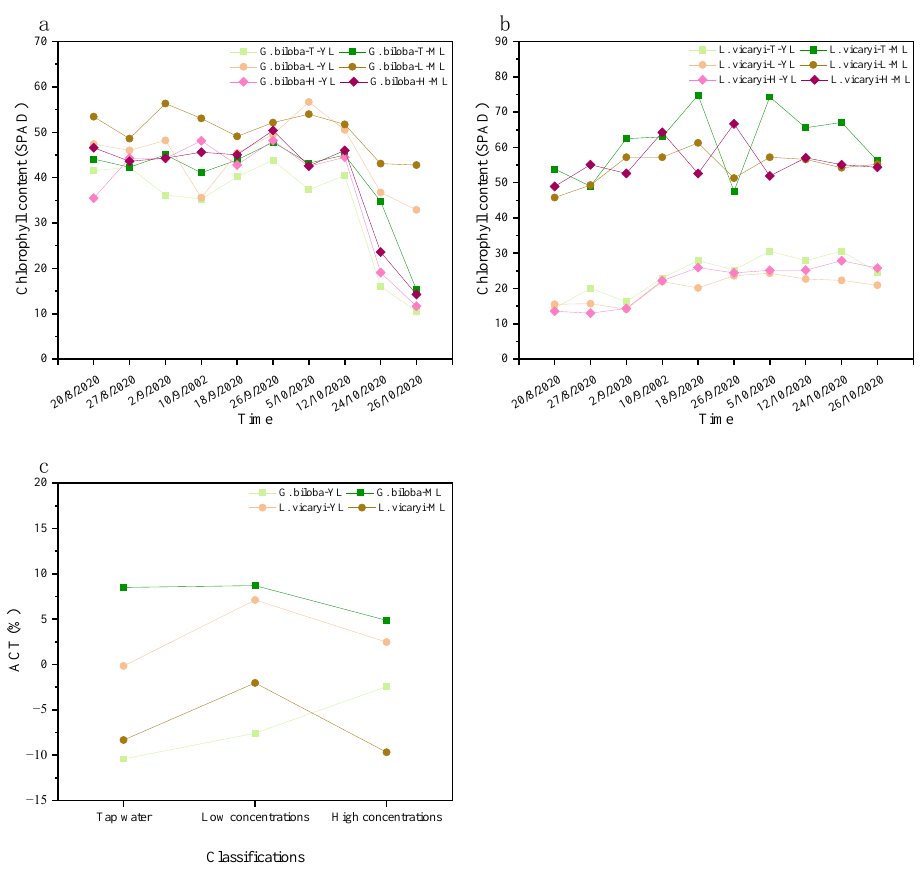
Figure 4. Changes in ( a ) Ginkgo biloba L. and ( b ) Ligustrum × vicaryi chlorophyll contents, n = 3; and ( c ) chlorophyll content ACT in the plants.